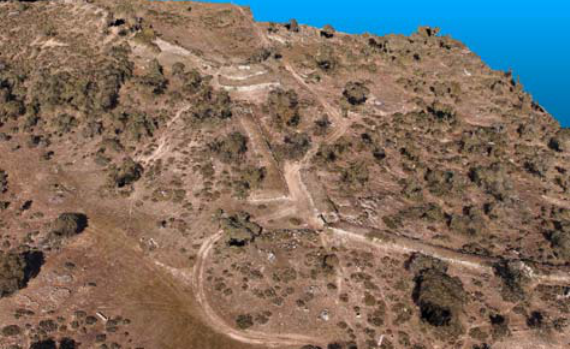
Figure 6. 3D model of the hillfort.